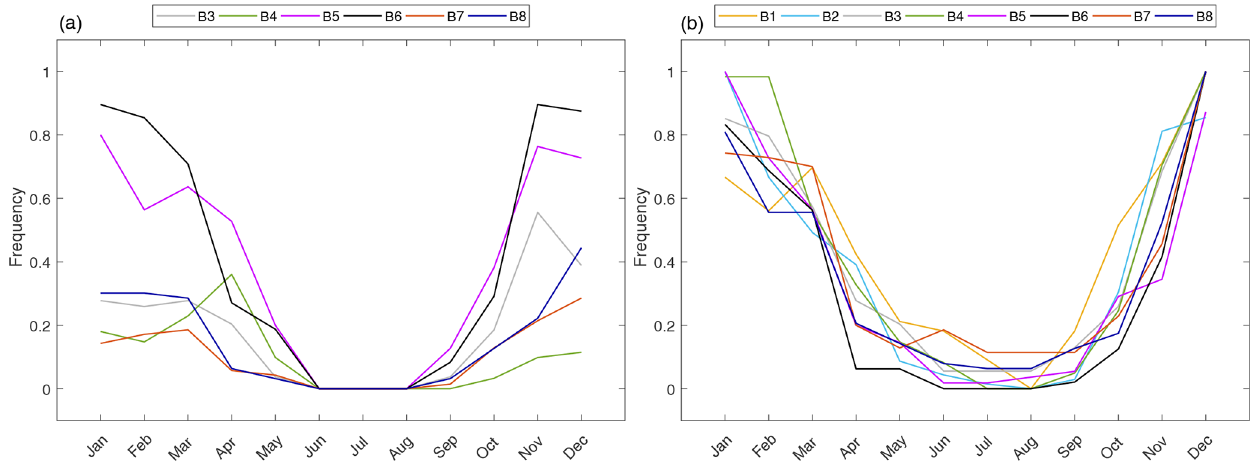
Figure 11. Normalized monthly frequency of occurrence of the extremes. (a) Events belonging to WP#1; (b) events belonging to